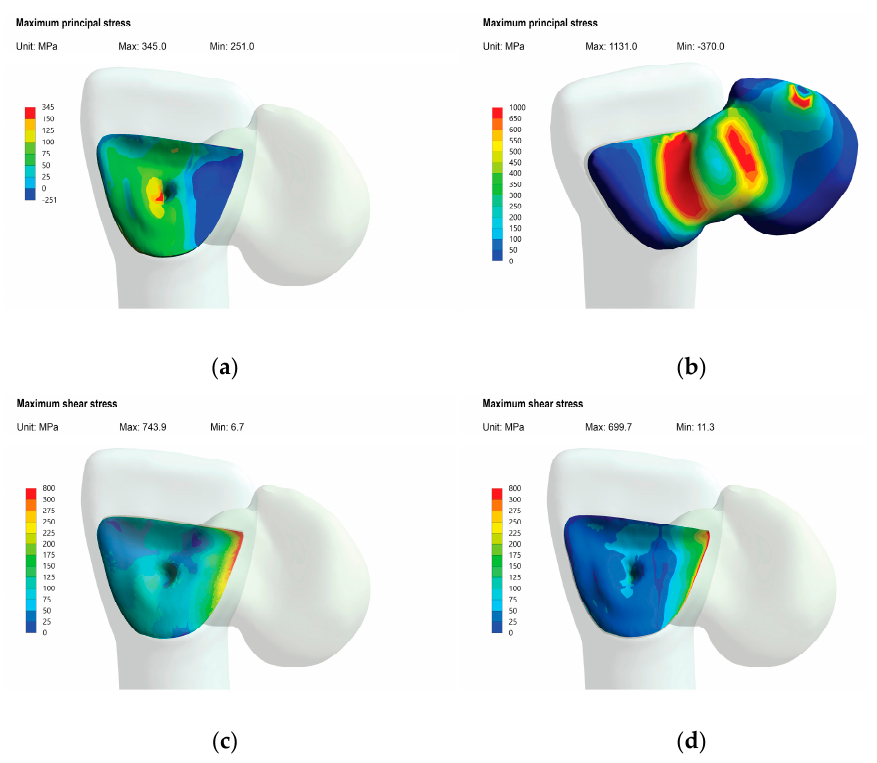
Figure 8. Calculated stresses represented in colorimetric stress maps (MPa). ( a ) Tensile stress in cement layer. ( b ) Tensile stress in RBFDP. ( c ) Shear stress at tooth–resin interface. ( d ) Shear stress at RBFDP–resin interface. RBFDP , resin-bonded fixed dental prosthesis; Max , maximal stress; Min , minimal